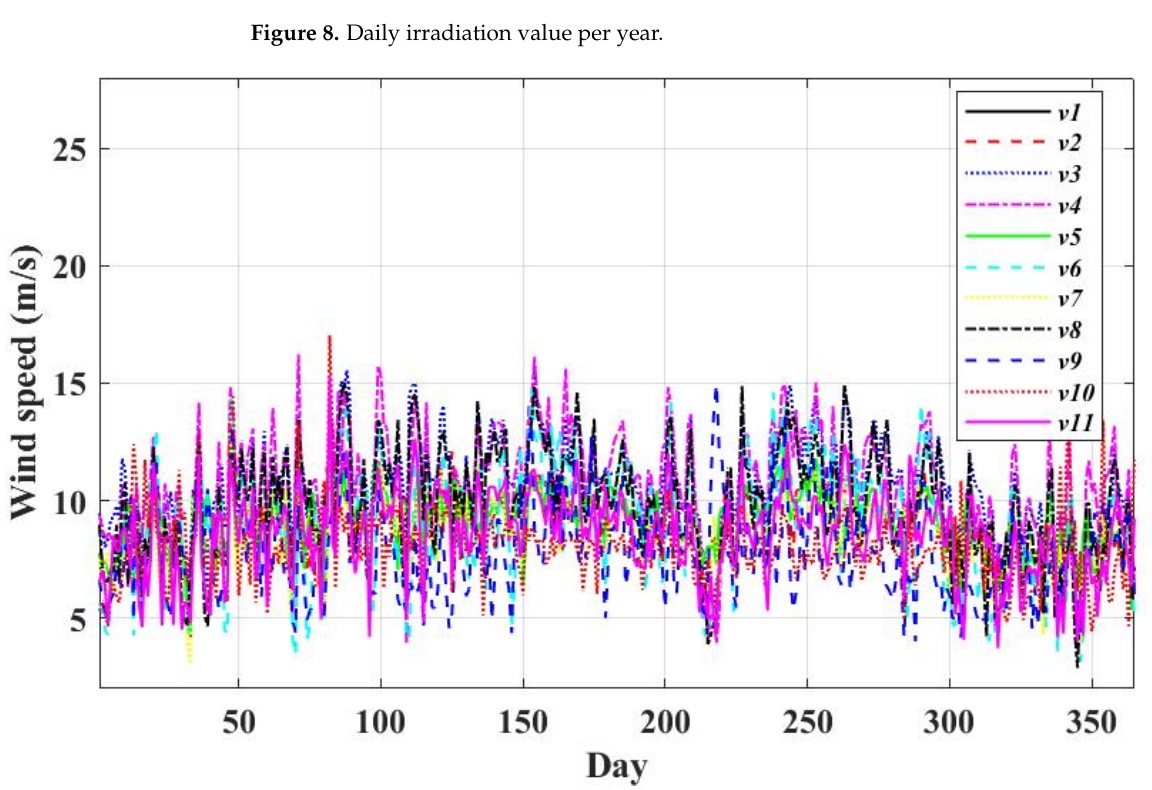
Figure 9. Daily wind speed value per year. Table 1. The 500 kV Egyptian power system data in 2022.